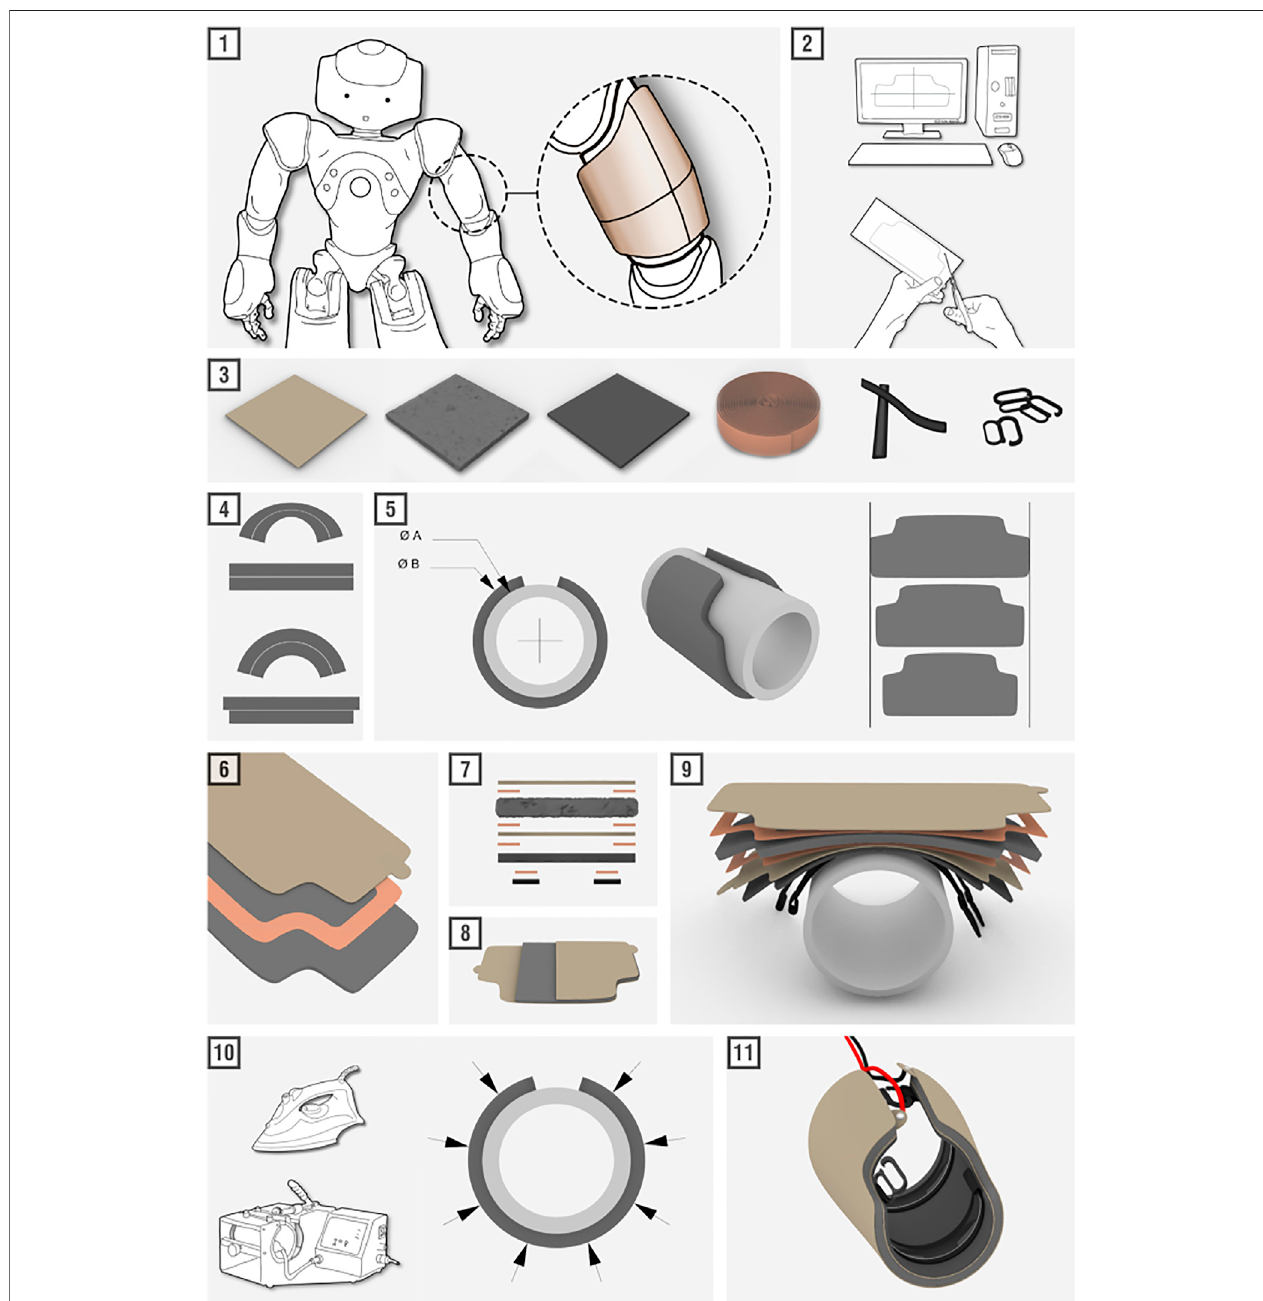
FIGURE 2 | A visual guide highlighting the eleven key steps required for building our fabric-based tactile sensors.